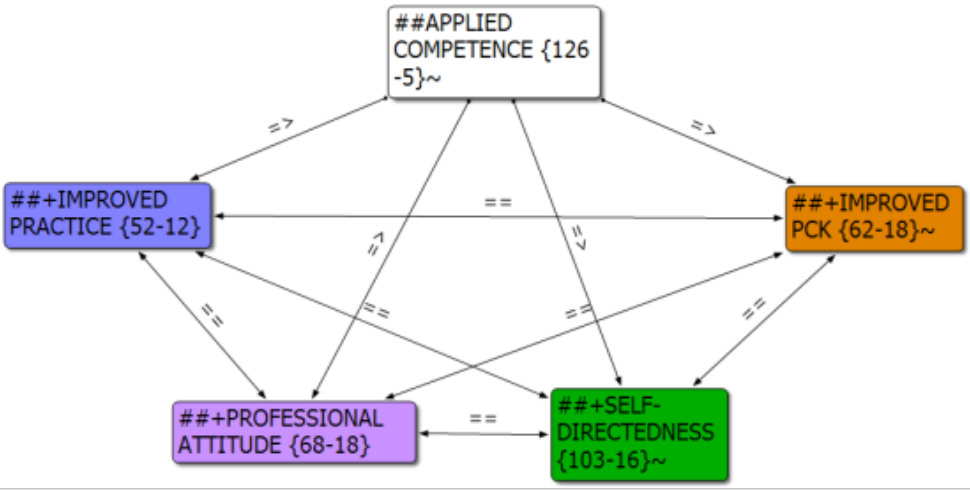
Figure 3 . Experience of the way the programme supported applied